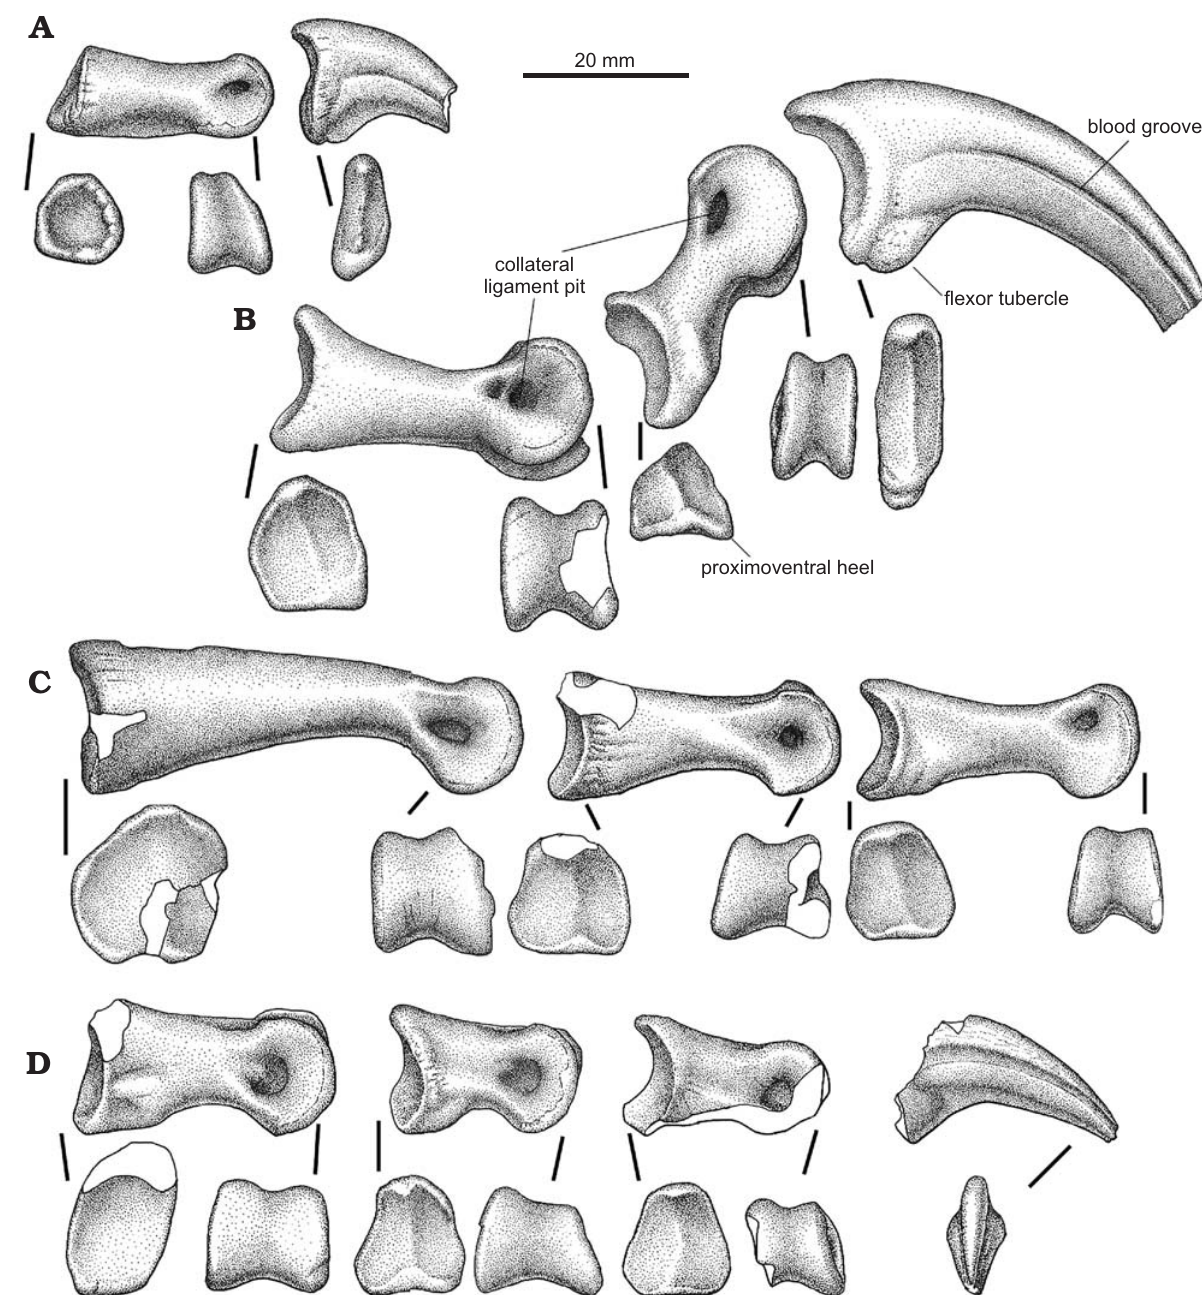
Fig. 9. Unenlagiid theropod Neuquenraptor argentinus Novas and Pol, 2005 (MCF PVPH 77) from Sierra del Portezuelo, Neuquén Province, Argentina; Portezuelo Formation, Coniacian, Late Cretaceous; left pedal phalanges: I ( A ), II ( B ), III ( C ), IV ( D ); in articular and medial